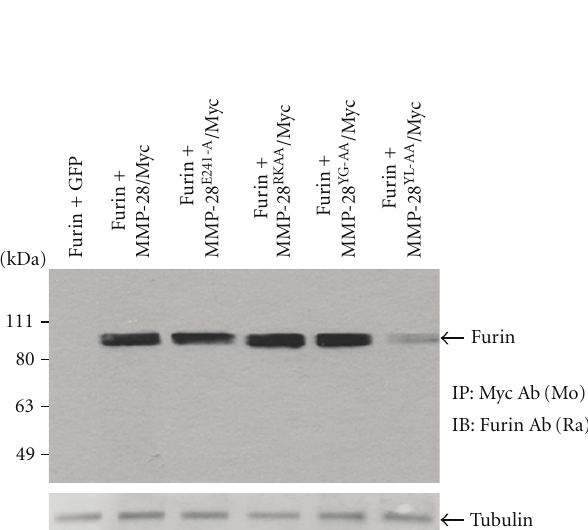
Figure 5: Requirement of the propeptide domain of MT1-MMP for complex formation with furin and the YL sequence of MMP-28 for complex formation and secretion. The YL motif within the propeptide of MMP-28 is